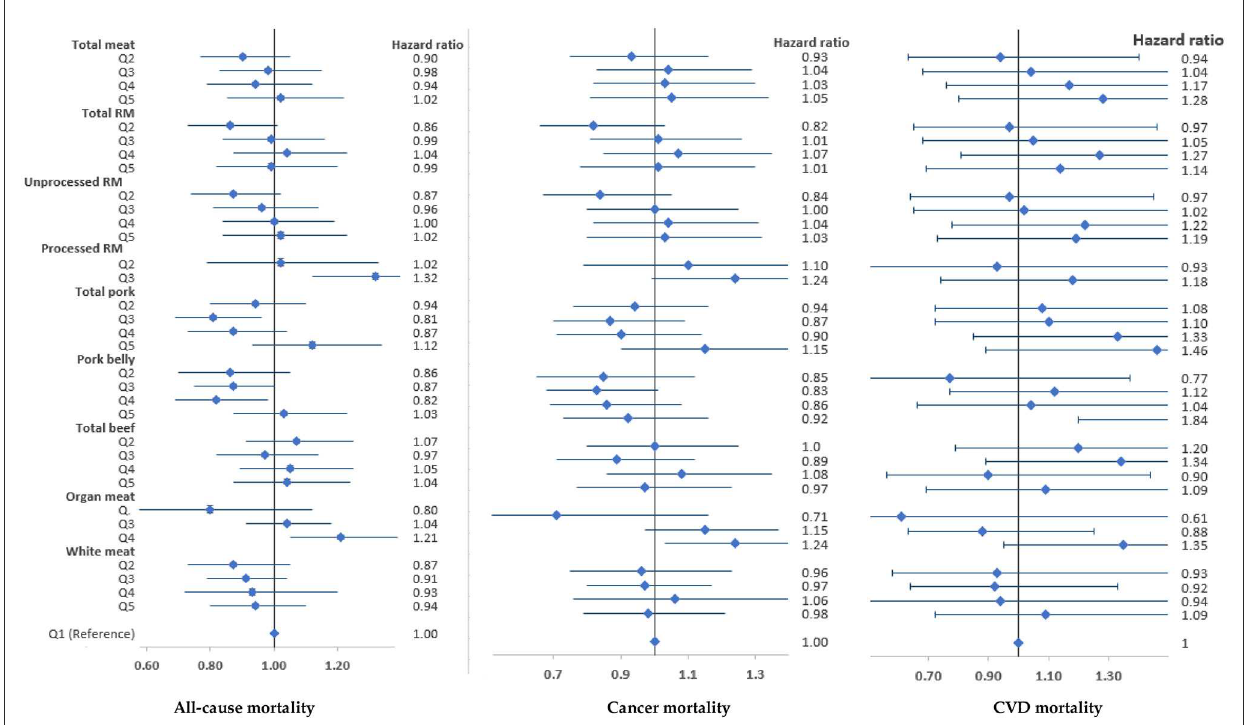
FIGURE3 Associations of meat intake with all-cause and cause-specific mortality in the HEXA-G study in women. Points are hazard ratios, and lines represent 95% confidence interval. Models were adjusted for baseline age, marital status, education, income, job, smoking, drinking, regular physical exercise, total energy intake, total meat intake (for specific meat types), history of chronic diseases, body mass index, and menopausal status. RM, Red meat. 95% confidence intervals, sample sizes and person-years are shown in Supplementary Table